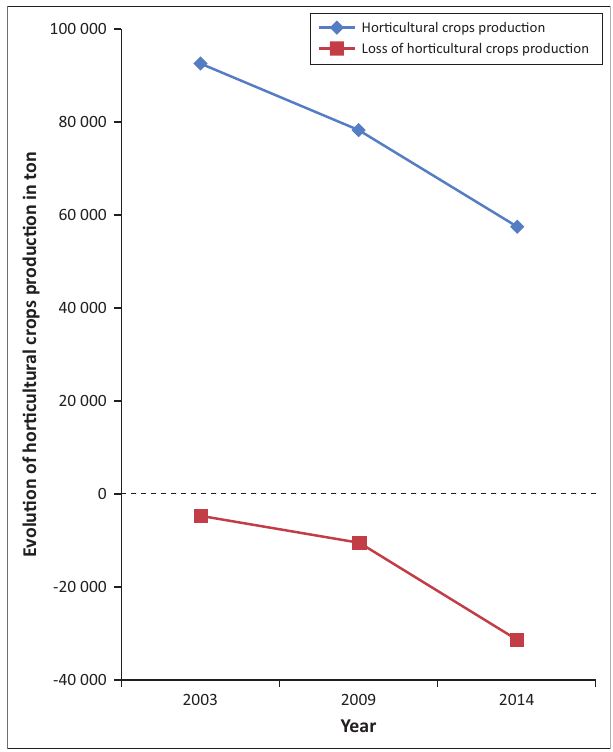
FIGURE 5: Changes in horticultural crops production as affected by the urbanisation and industrialisation process.